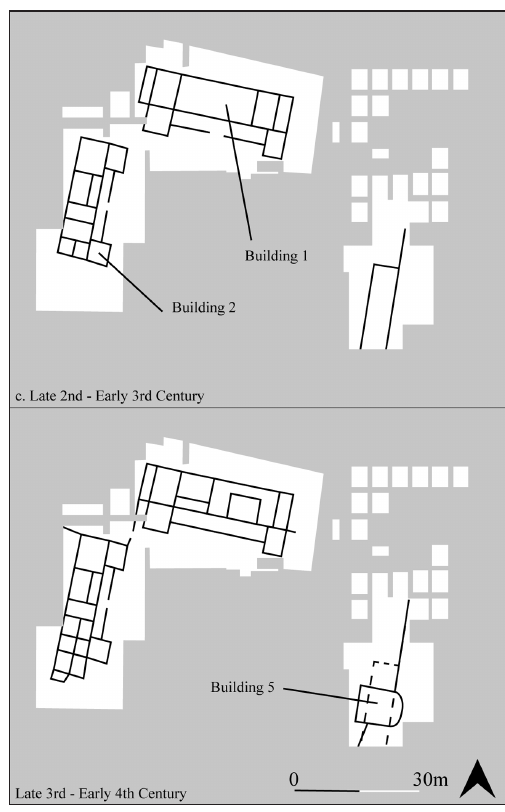
Figure 2: The development of the courtyard villa at Beadlam showing the excavated areas, building numbers mentioned in the text, and the structural sequence until the early fourth century AD (J.